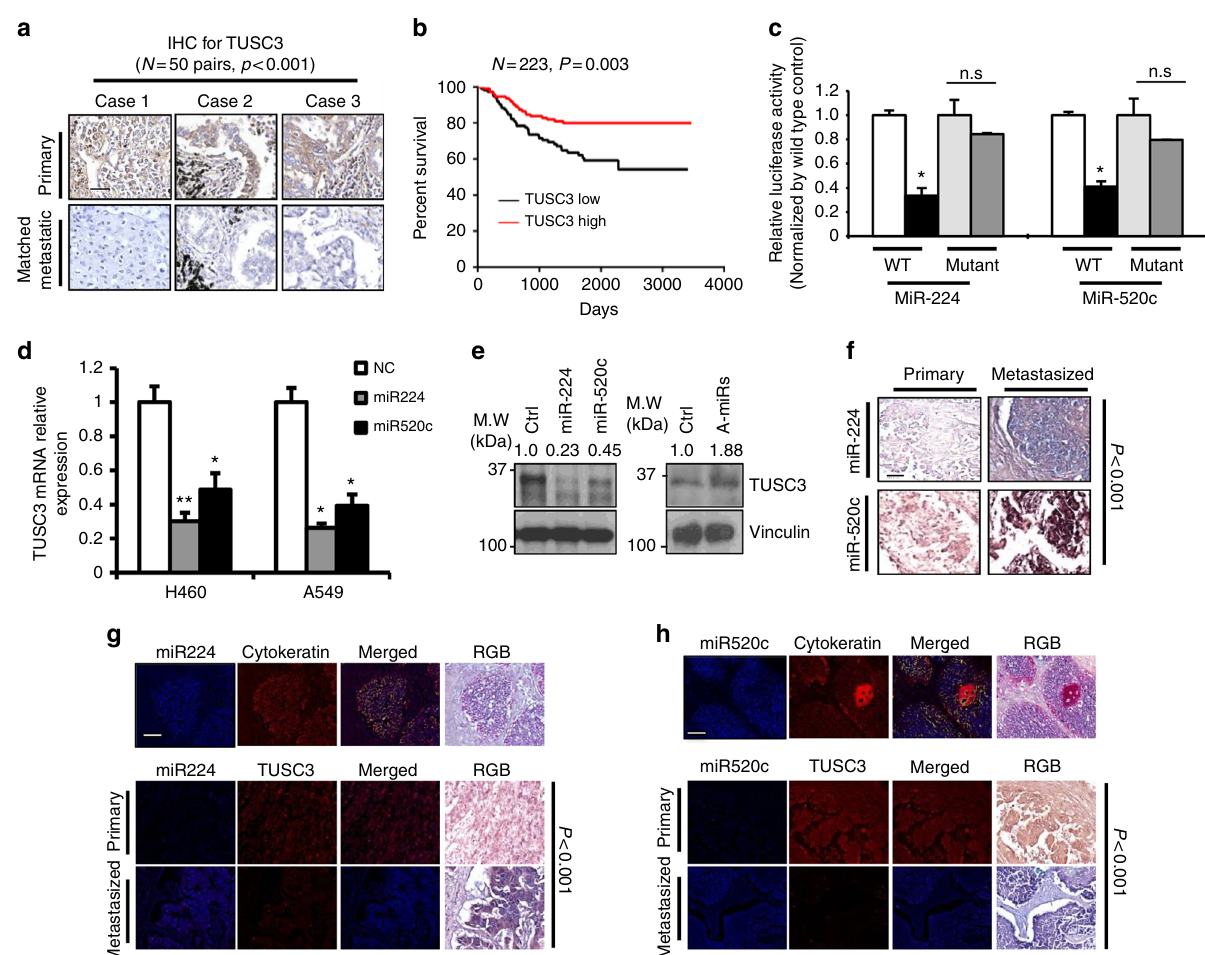
Fig. 1 miR-224 and -520c are responsible for TUSC3 de fi ciency in metastasized lung cancer patient tissues. a Expression analyses of TUSC3 by immunohistochemistry (IHC) showing suppressed expression in matched metastatic samples. 50 primary and their matched lymph node metastasized lung tumor tissues were analyzed. The summarized expressional scores are shown in Supplementary Fig. 1b. P -value was obtained by Pearson ’ s chi- squared test. b PrognoScan based Kaplan Meier plot showing decreased patient survivals associated with TUSC3 de fi ciency (GSE31210). c Luciferase reporter assays with TUSC3 3 ’ UTR in miR-224 or -520c-overexpressing HEK293 cells. The pGL3-TUSC3-3 ’ UTR plasmid or the mutants harboring deleted target sequences for miR-224 or miR-520c were co-transfected with miR-224 (left panels) or miR-520c (right panels). The relative values were obtained by normalizing to Renilla luciferase values. Bars represent means ± SD ( n = 4) and the p -values were determined by two-tailed student t -test (* p < 0.001). d Decreased TUSC3 mRNA expression in miR-224 or miR-520c overexpressing NSCLC. Bars indicate means ±SD ( n = 3) and p -values were addressed by two-tailed student t -test (* p < 0.01, ** p < 0.05). e Western blot analyses showing that miR-224 and miR-520c suppressed the endogenous TUSC3 protein in A549 (left panel) and H460 (right panel) cells. Pre-miR-224/-520C (left) or anti-miR-224/-520c (right) were ectopically expressed in A549 (left) or H460 (right) cells. f In situ hybridization showing the enhanced miR-224 and miR-520c expression in lymph node metastasized lung tissues compared to their corresponding primary tumors. Total numbers of cases were summarized in Supplementary Fig. 1e. g , h Co-expression analyses of TUSC3 and miR- 224 ( g ) and miR-520c ( h ). The images in the miR-224 and miR-520c sections show a lung adenocarcinoma after co-expression of TUSC3 ( fl uorescence red and RGB brown) with miR-224 ( g , fl uorescence blue and RGB blue) or miR-520c ( h , fl uorescence blue and RGB blue). The chi-squared test statistic was generated and the null hypotheses that the expression of TUSC-3, miR-224, and miR-520 was equal in primary versus the metastatic tumors or that the expression of TUSC3 and a given miRNA was equal in the primary and metastatic tumors tested using 2 degrees of freedom. The scale bars indicate 150 µ m ( a ), 100 µ m ( b ), and 200 µ m ( g , h ),